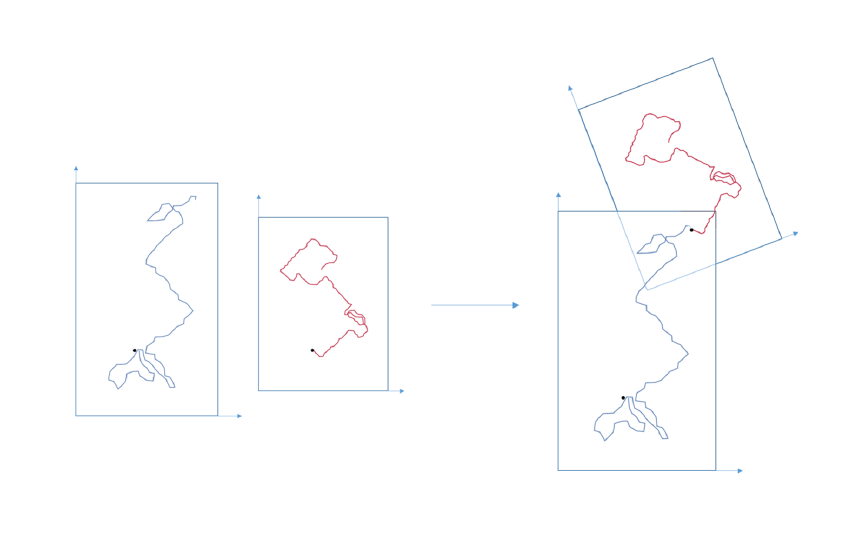
Figure 7. Two patches of pure bimodal trajectories with the same parameters b = − 0.877, d = 0, which compose the mixed bimodal trajectory on the right, with a rotation of 20 o between them.